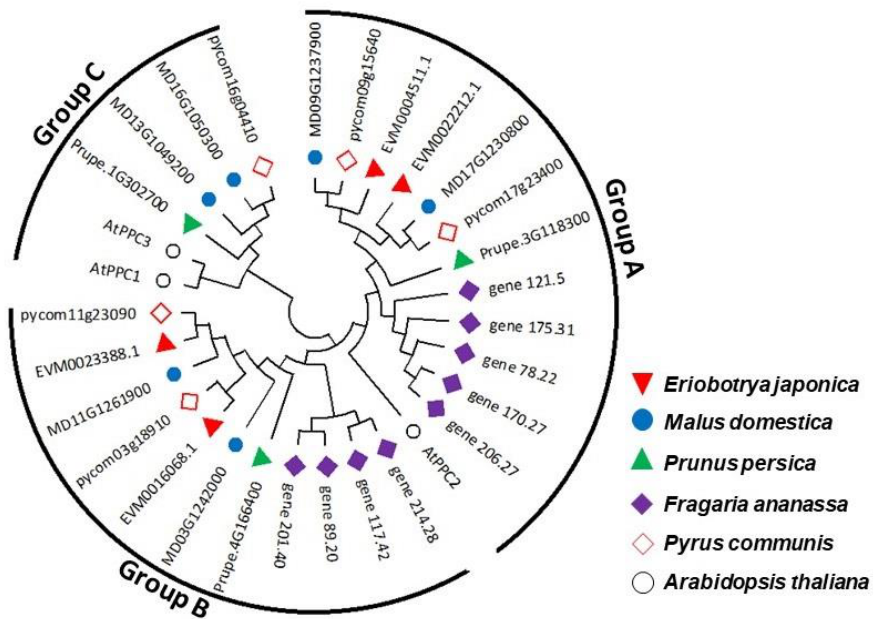
Figure 2. Phylogenetic tree analysis of PEPC genes in five Rosaceae species using the neighbour- joining (NJ) method.